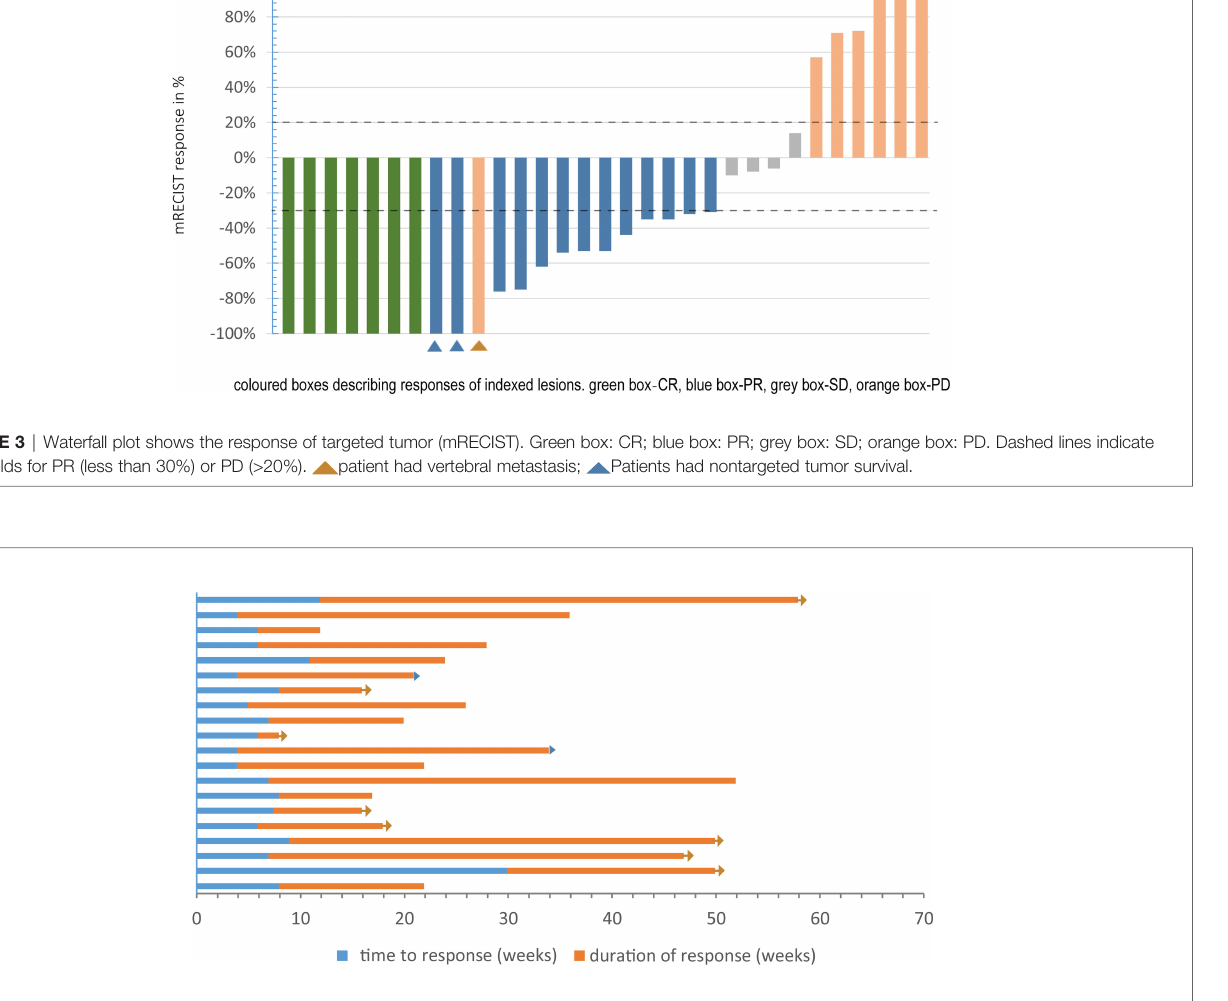
FIGURE 4 | Response and duration for 20 patients with best overall response of ORR (CR or PR), unit: weeks. response ongoing at last assessment death at last